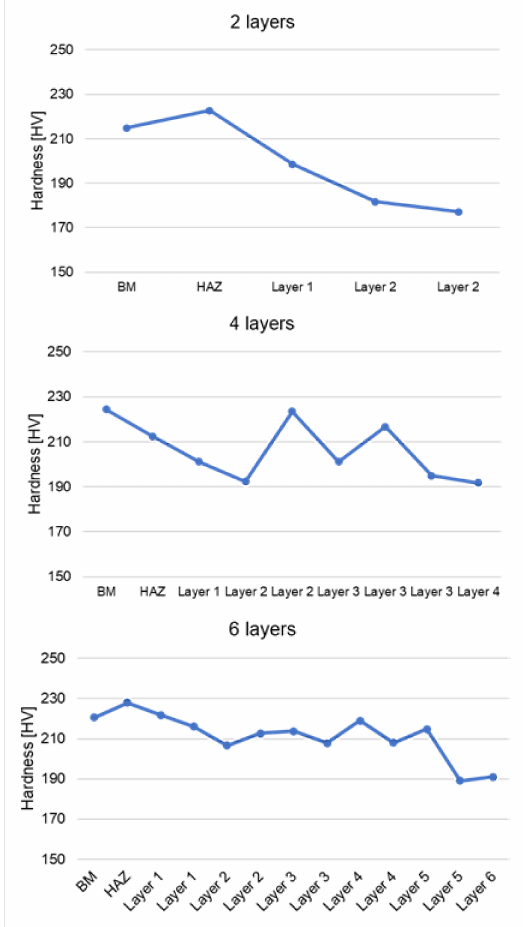
Figure 6. Variation in hardness along the deposited layers.